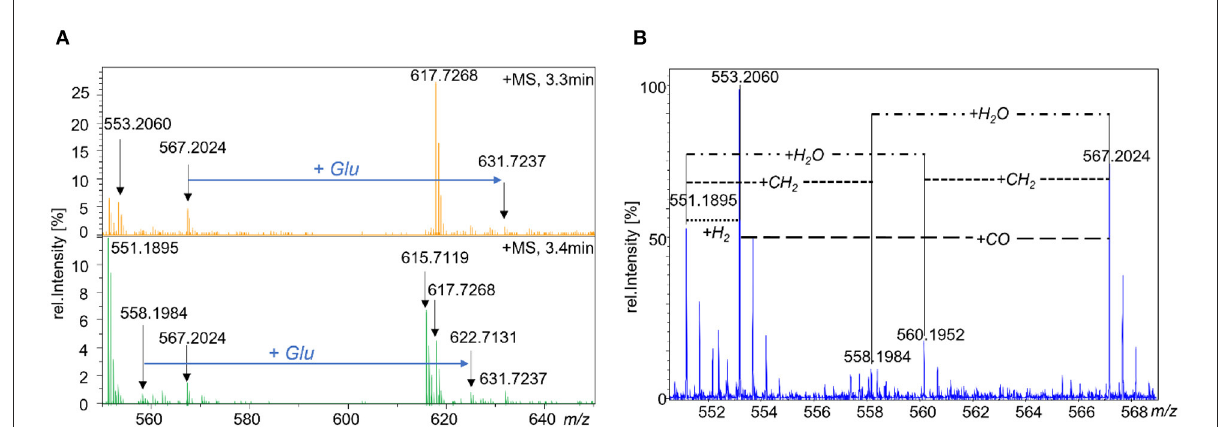
FIGURE5 MS-spectra of cultured TUM68 ® yeast analyzed by UPLC-Q-ToF-MS. with (A) MS 1 -spectra showing the putative folate vitamers of metabolite group 1 ( m/z 558.1984 and m/z 622.7131) and metabolite group 2 ( m/z 567.2024 and m/z 631.7237) and the mass difference between the features of each group referring to the incorporation of an additional glutamate moiety. (B) MS 1 spectrum showing known and putative folate hexaglutamates with m/z 551.1895 = 5,10-CH + -H 4 PteGlu 6 , m/z 553.2060 = 5-CH 3 -H 4 PteGlu 6 , m/z 558.1984 = hexaglutamate metabolite group 1, m/z 560.1952 = MeFox-Glu 6 /5-CHO-H 4 PteGlu 6 , m/z 567.2024 = hexaglutamate metabolite group